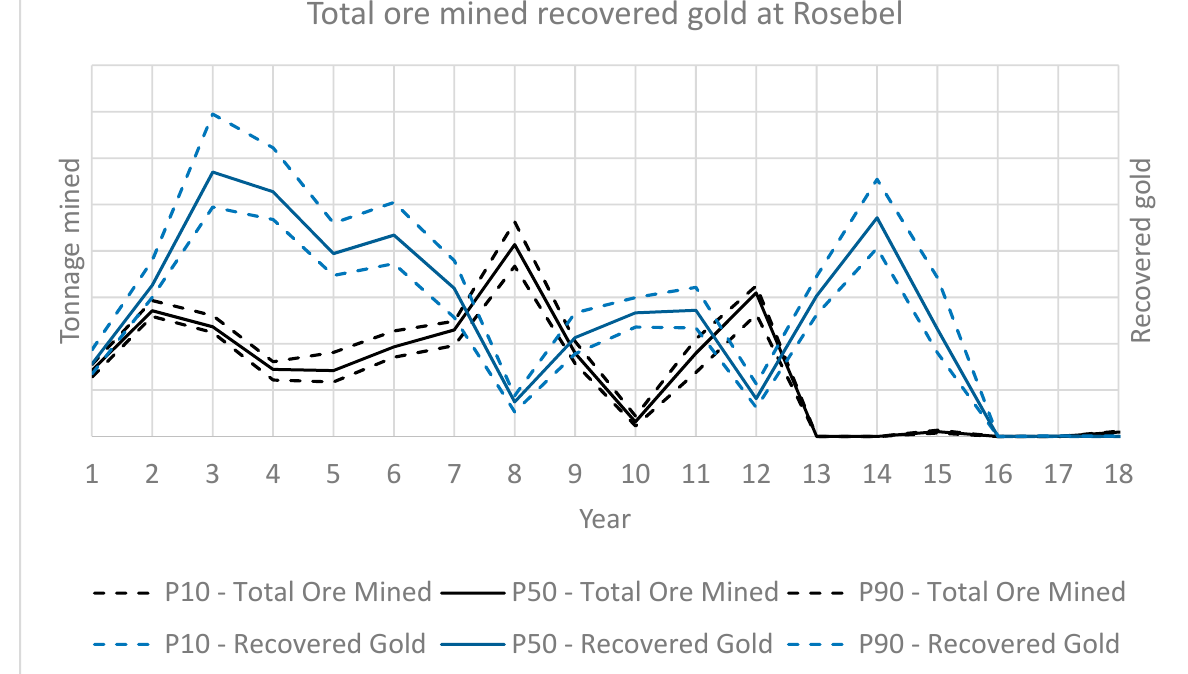
Figure 6. Ore tonnage mined and recovered gold at the Rosebel Mine.